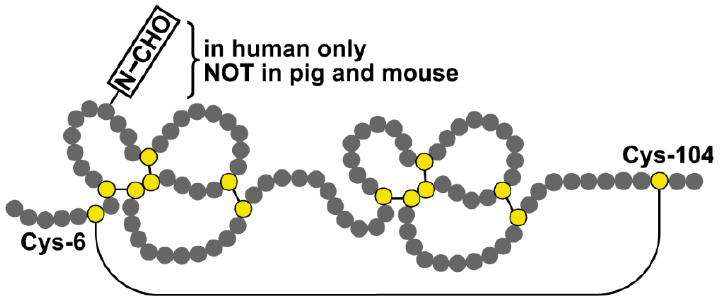
Figure 1. Disulfide-linked schematic structure of TFF2. Cysteine residues are shown in yellow. The N-linked carbohydrate moiety typical of human TFF2 is indicated.